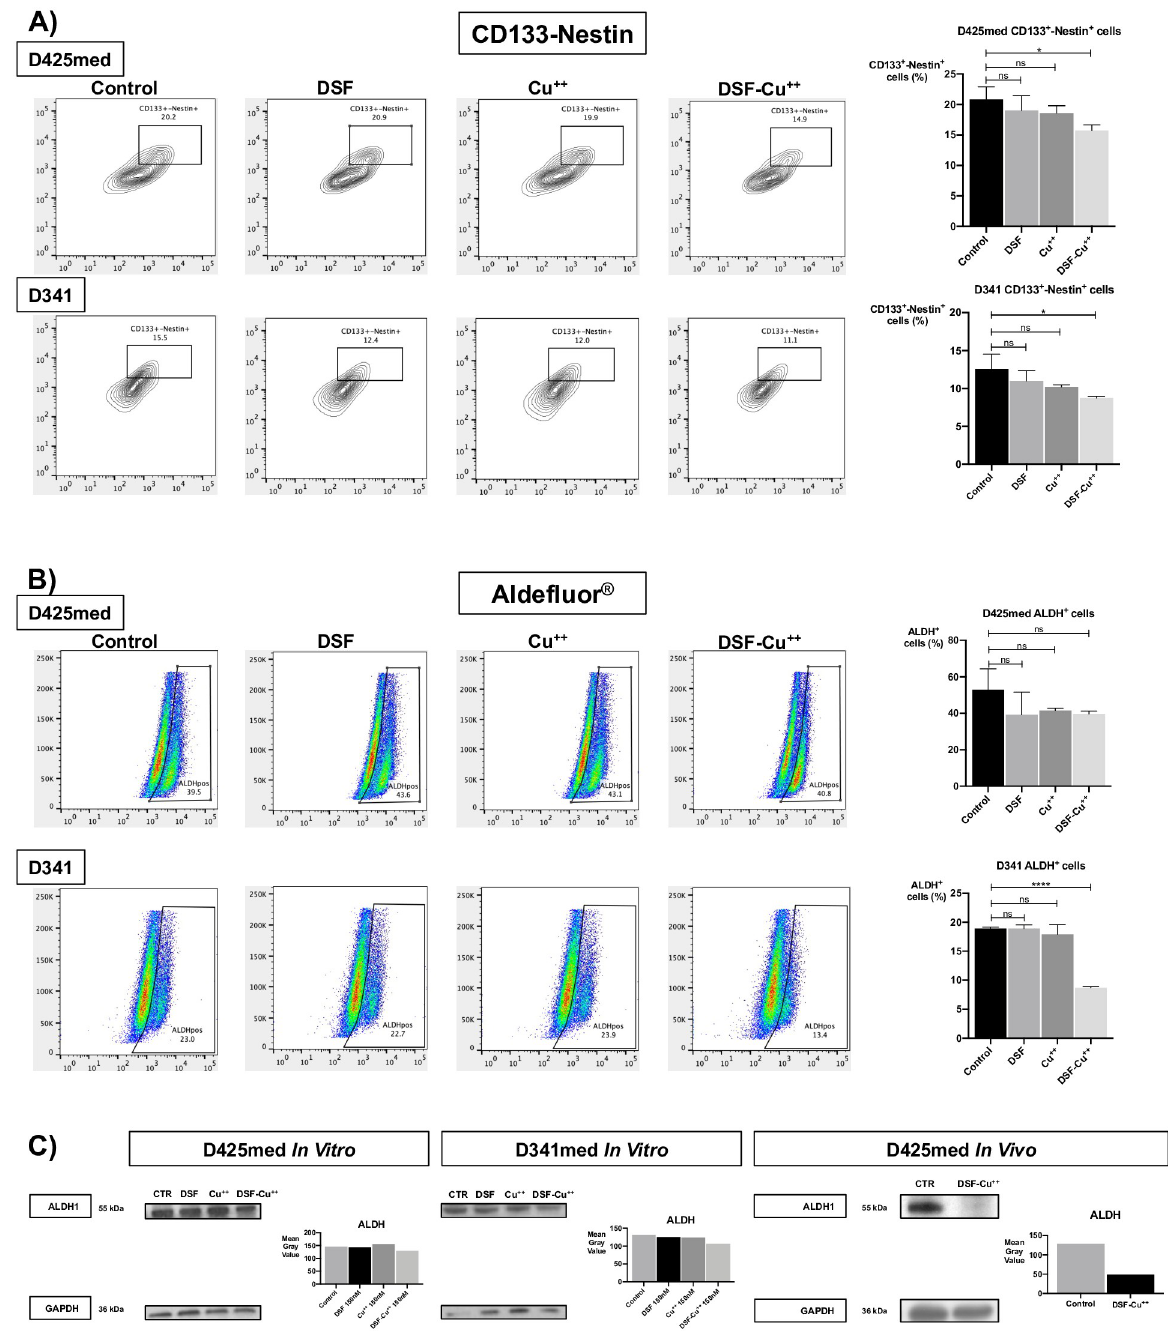
Fig 2. DSF-Cu ++ reduces CD133 + -Nestin + and ALDH + cancer cells in D425med and D341 lines. (Panel A) CD133 + -Nestin + D425med and D341 cells were significantly reduced by treatment with DSF-Cu ++ 150nM for 12h, while no significant effect was noticed in cells treated with DSF and Cu ++ only. Similarly, a reduction in ALDH, a key enzyme in stem-cells maintenance, was detected in DSF-Cu ++ -treated cells, with minimal effect of DSF and Cu ++ only (Panel B) . Western blotting confirmed a significant reduction in ALDH expression after combination therapy, both in vitro and in vivo (Panel C)